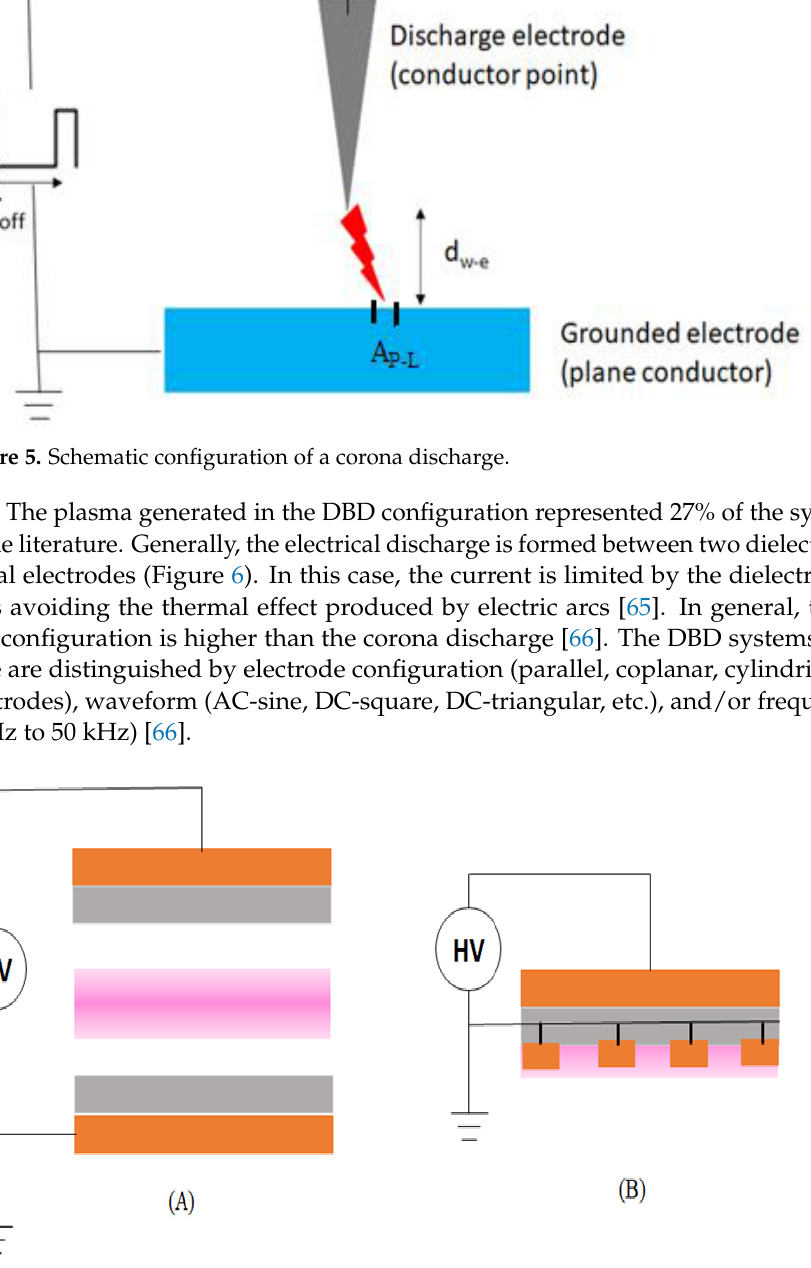
Figure 7. Plasma generation methods for saline-based water treatment, where PiL refers to the con- figuration in which the plasma is immersed in the liquid, and PoL to those configurations where the plasma is applied to the surface of the saline liquid.